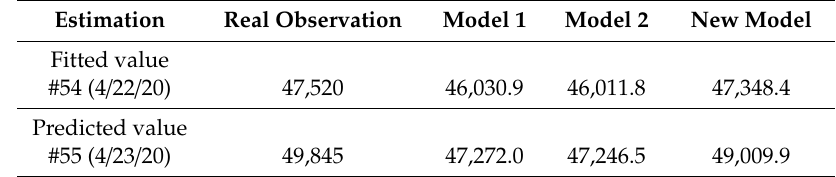
Table 6. Prediction results.